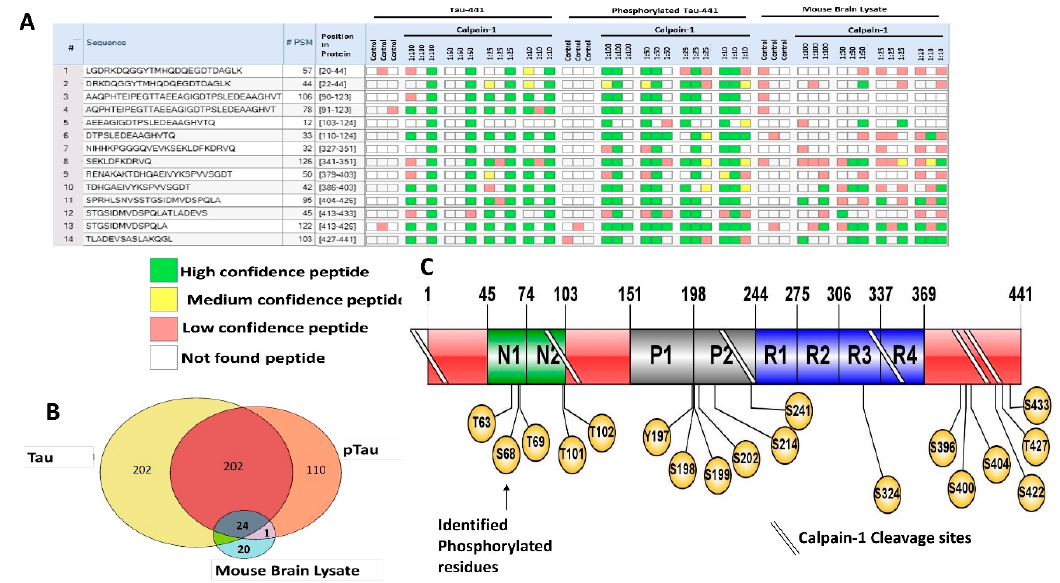
Figure 5. Composite summary of calpain-mediated tau proteolytic peptides and phosphorylation sites. ( A ) A spreadsheet showing calpain-mediated proteolytic peptides identified from Tau, p-tau, and mouse brain lysate ultrafiltrate samples. This table listing shows the confidence of each peptide in each fraction. Not found peptide is represented as white. Green represents high confidence peptides. Yellow represents medium confidence peptides. Red represents low confidence peptides. Each box represents a biological replicate, and each experiment was done at least n = 3. ( B ) Venn diagram showing the total number of peptides released in each of the biological replicates from the different samples. ( C ) A schematic representation showing the domains of tau protein and displaying the location of phosphorylation identified by nano-LC/MS/MS and predicted calpain cleavage sites derived from in this study. All tables and diagrams created using the proteome discoverer 2.2.